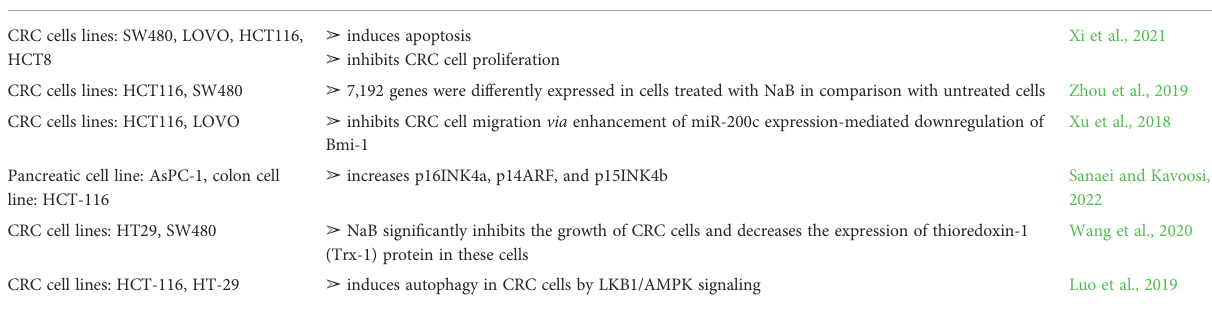
TABLE 1 Summary of the anti-tumor activity of NaB. CRC — colorectal cancer. Cells lines NaB ’ s mechanism of